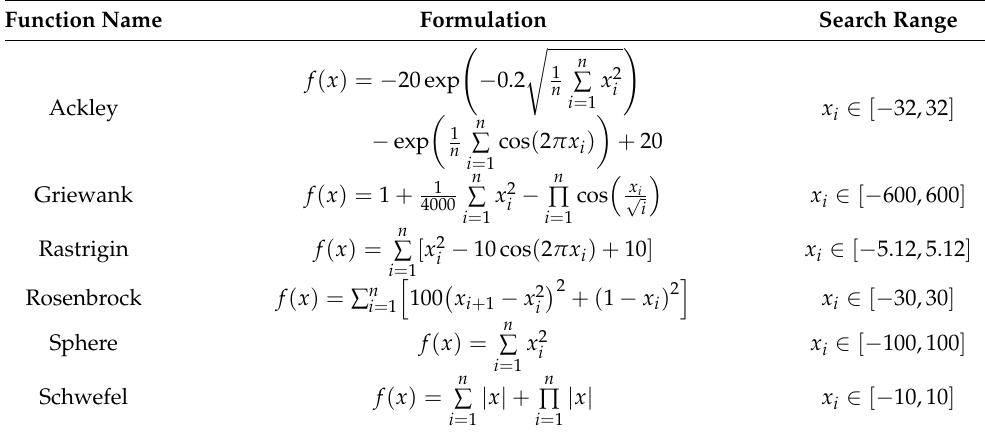
Table 1. Standard test functions and parameter settings.